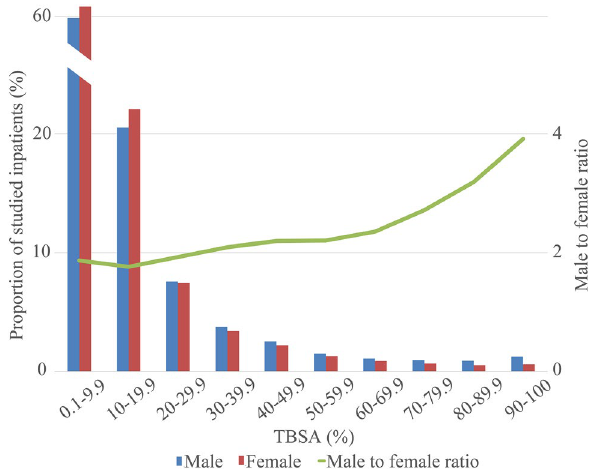
Figure 4. Proportions of burned male and female inpatients along with the male to female ratio in different TBSA burned groups. The X-axis represents the percentage of TBSA burned groups. The left Y-axis corresponding to the bars represents the proportion of each group in the studied population. The right Y-axis corresponding to the line graph represents the values of male to female ratio. Abbreviations: IOC the incidence of scar contracture associated re-hospitalisation. TBSA total body superficial area.